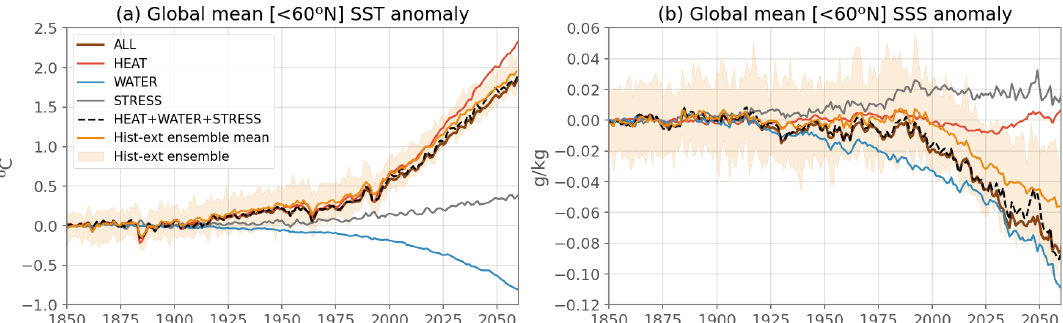
Figure 13. Evolution of global mean sea surface temperature (a) and salinity (b) anomalies, excluding the Arctic (i.e., global average south of 60 ◦ N), for the ocean-only ALL simulation (brown), HEAT (red), WATER (blue), STRESS (grey), the sum of HEAT, WATER and STRESS (dotted black), and the coupled model historical ensemble mean (orange). The ensemble mean anomaly is taken as the difference at each time step from the 1850–1899 average. The anomalies in the ocean-only experiments are computed at each time step as the difference between each experiment and CTL, before removing the 1850–1899 average, to be consistent with the ensemble mean